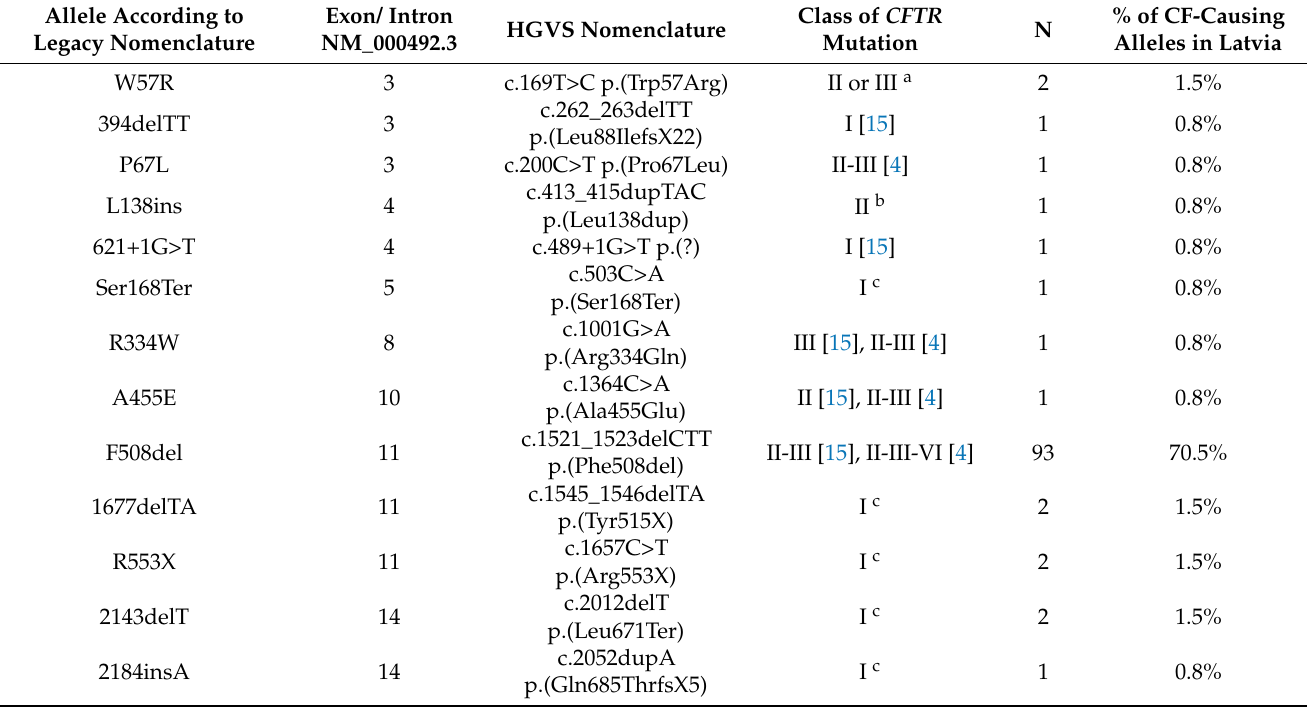
Table 1. Frequency and pathogenicity class of CFTR CF-causing variants found in 66 unrelated Latvian